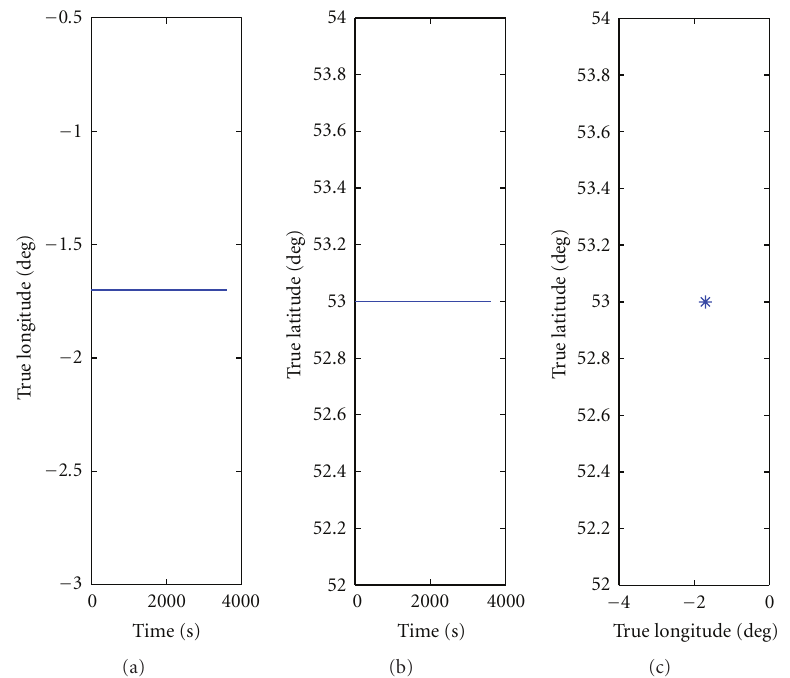
Figure 9: The designed trajectory of static